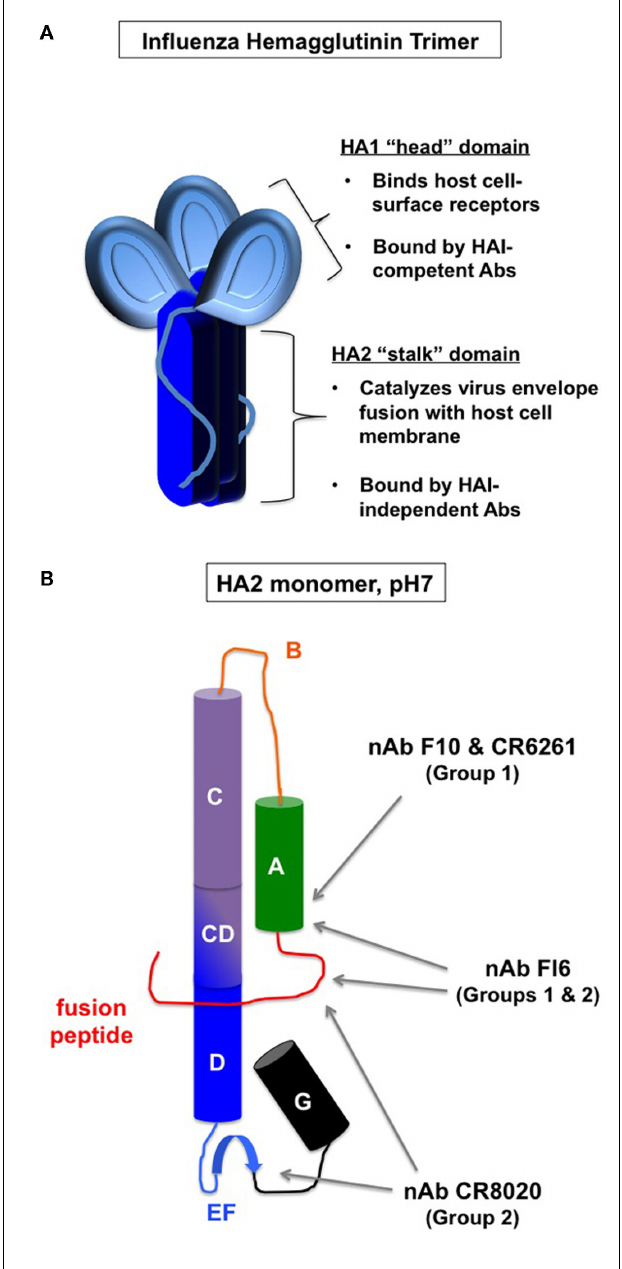
FIGURE 1 | Neutralizing antibody binding to hemagglutinin. (A) Gross structure of the hemagglutinin (HA). HA1 ( light blue ) makes-up most of the globular head domain as well as a polypeptide extension into the stalk area. HA2 ( dark blue ) makes-up the membrane-proximal stalk domain. (B) Schematized secondary structure of HA stalk monomer (HA2) in the pre-fusion conformation (adapted from Han and Marasco, 2011). Cylinders represent α helices and broad blue arrow represents a β sheet. Middle red line represents N-terminal fusion peptide. Previously defined subdomains are labeled with capital letters. Gray arrows point to epitope locations for the indicated broadly neutralizing antibody clones (nAb, see Table 1